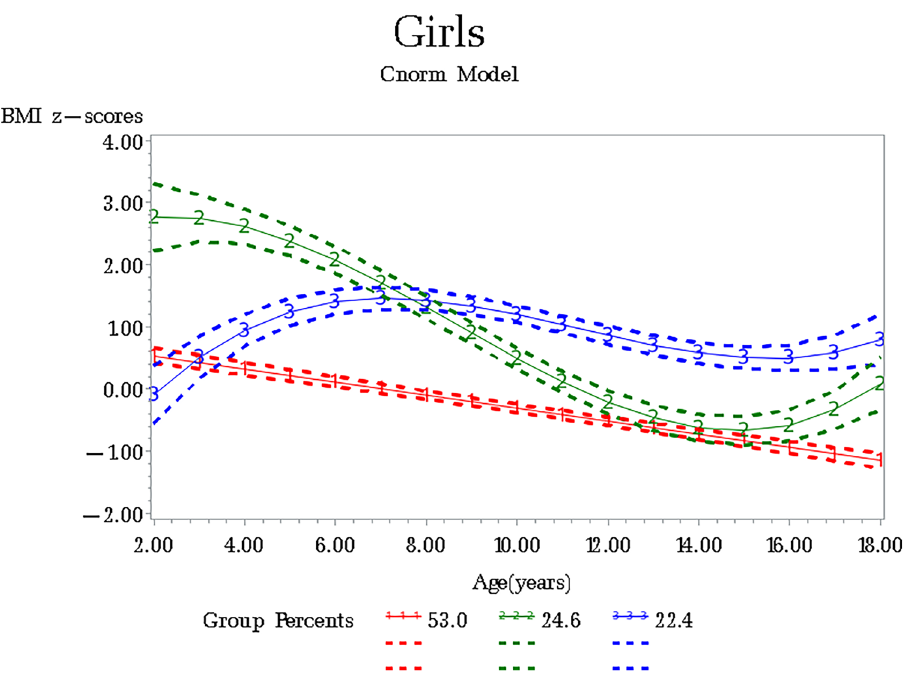
Figure 2. BMI z-scores trajectory groups among girls aged from 2 to 18,